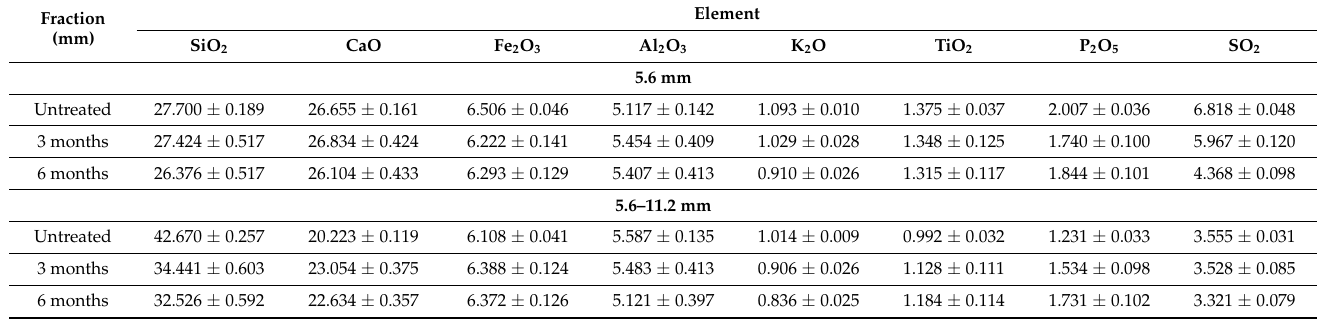
Table 2. Bulk chemical composition of untreated BA and BA after 3 and 6 months of